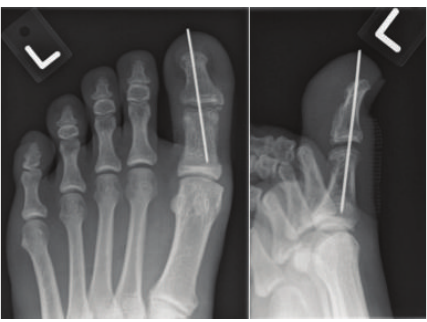
Figure 5: These are the radiographs obtained 2 weeks postopera- tively showing an enlocated IP joint of the left great toe with the Kirschner-wire well